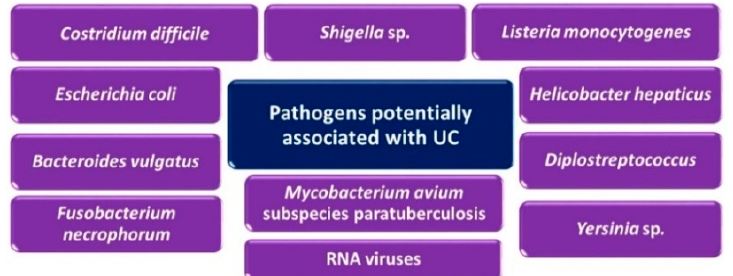
Figure 3. Pathogens potentially associated with the formation or development of ulcerative colitis (UC) [30,40].